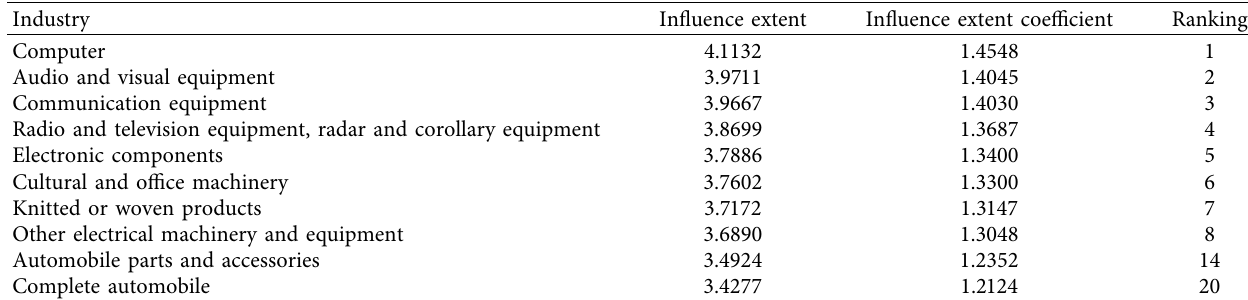
Table 9: Ranking of influence extent and influence extent coefficient of automobile industry